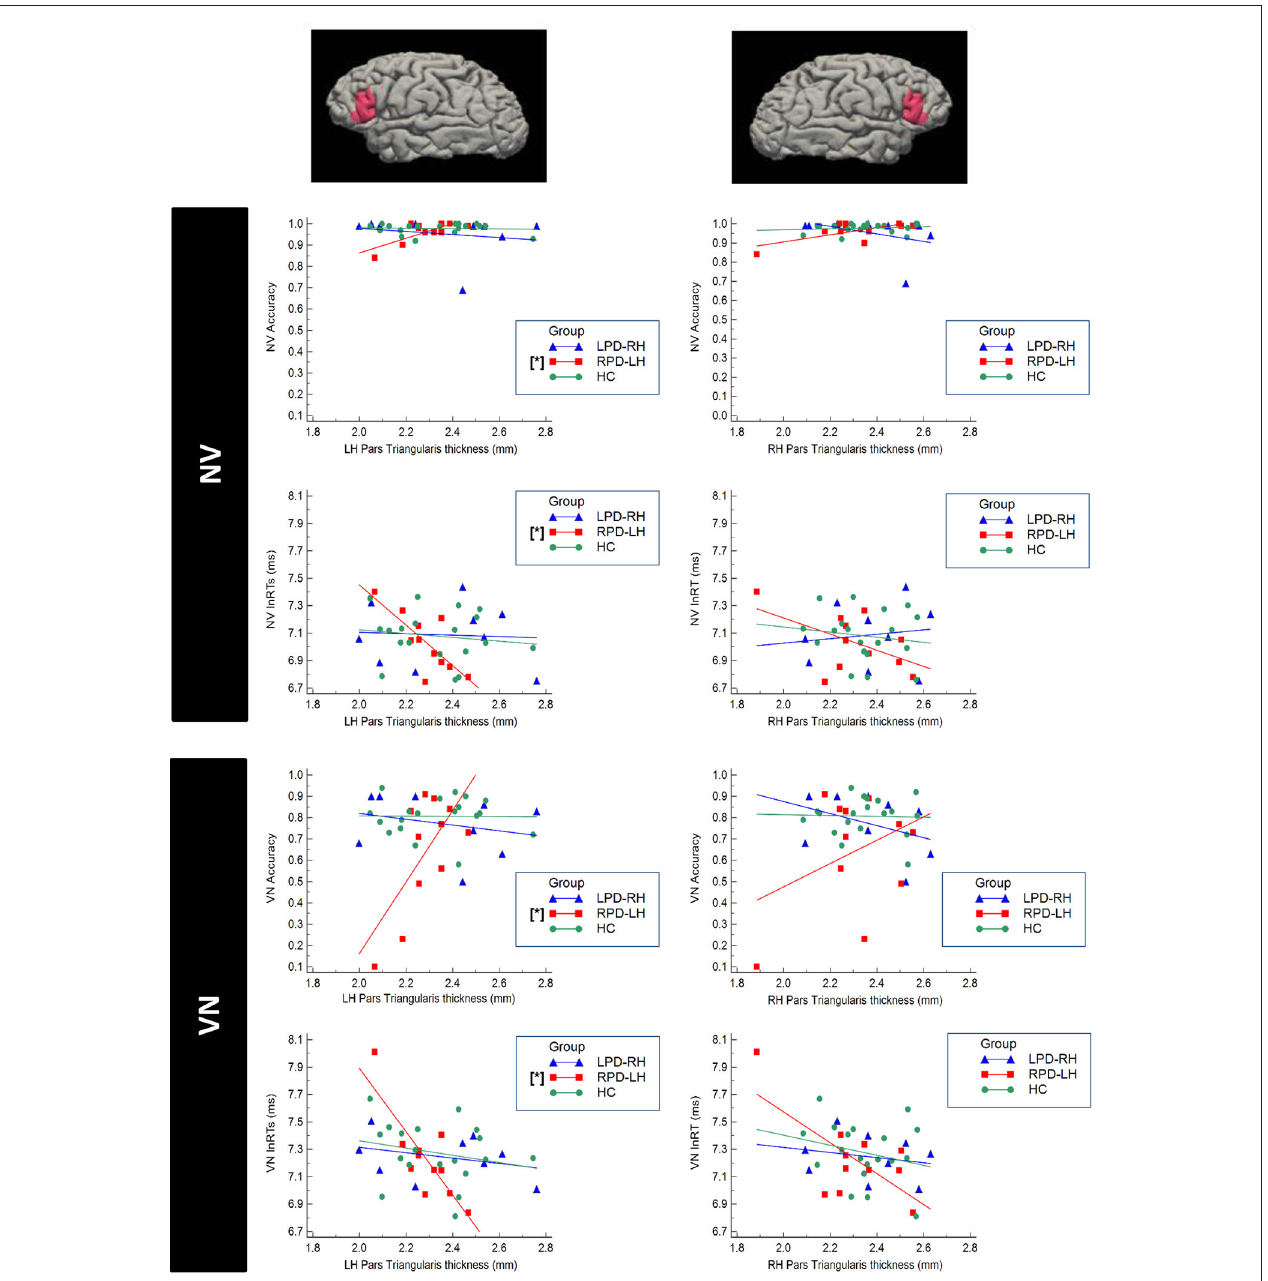
FIGURE 4 | Scatterplot representing the correlation between cortical thickness of the Pars Triangularis of the Inferior Frontal Gyrus (IFG) and performance at the verbal test in HC (healthy controls), RPD-LH (PD with prevalent left hemisphere nigrostriatal hypofunctionality), LPD-RH (with prevalent right hemisphere nigrostriatal hypofunctionality. Significant correlations ( p < 0.05 FDR-corrected) are marked by [*]. NV, verb from noun task; VN, noun from verb task; lnRTs, (log-transformed) reaction